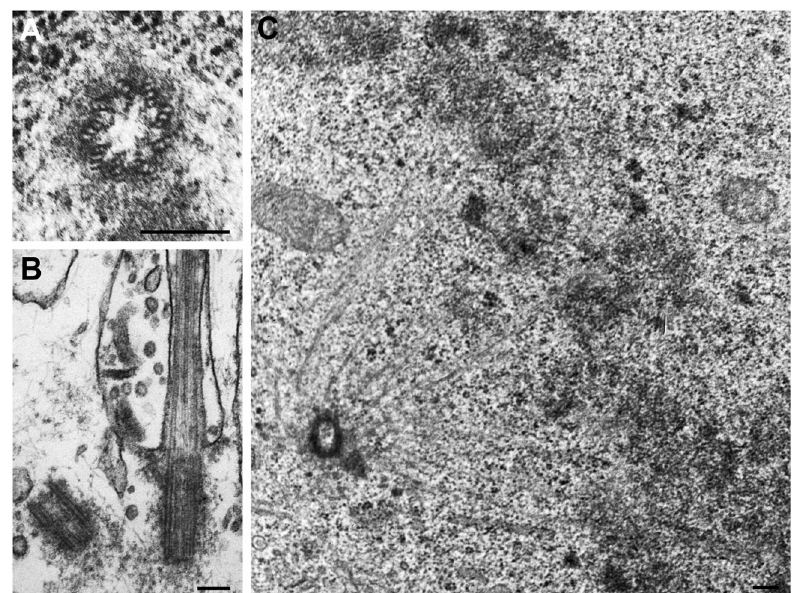
Fig. 1 The ultrastructure of centrosomes and cilia. Transmission electron microscopy images of ( a ) the nine-fold symmetry of centriolar microtubule triplets in a human U2OS cell, ( b ) a primary cilium in a human RPE-1 cell and ( c ) a centrosome at one of the poles of a mitotic spindle in a chicken DT40 lymphocyte. Scale bars, 200